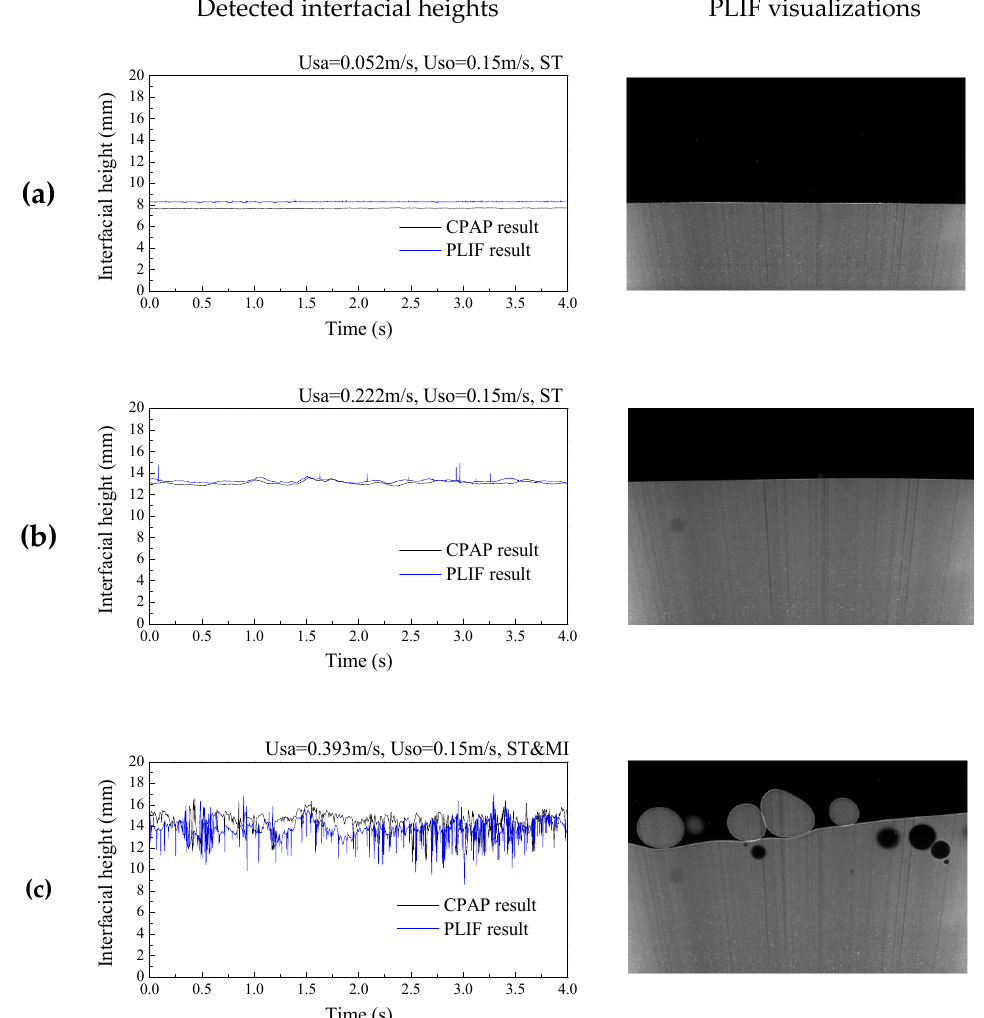
Figure 13. Comparison of the derived liquid-liquid interface heights by the PLIF and CPAP: ( a ) Usa = 0.052 m / s, Uso = 0.15 m / s, ST; ( b ) Usa = 0.222 m / s, Uso = 0.15 m / s, ST; (c) Usa = 0.393 m / s, Uso = 0.15 m / s, ST&MI.